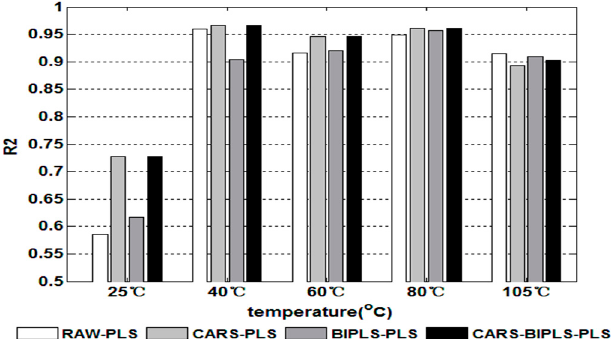
Figure 5. The comparison of different algorithms.